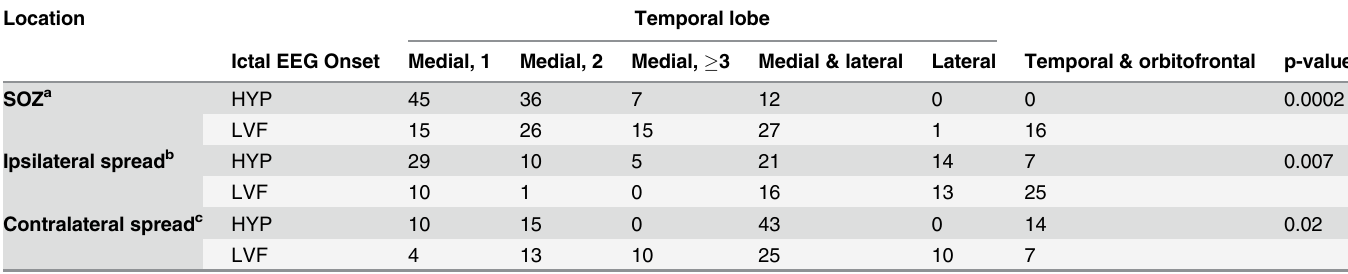
Table 2. Extent of SOZ and initial seizure spread.